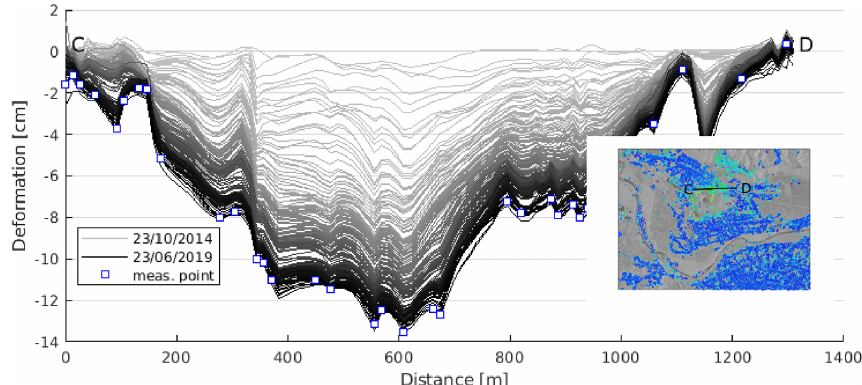
Figure 10. Progress of LOS surface deformation from descending pass Sentinel-1 data. Location of cross section is given in the insert. The shade of gray varies from light (October 2014) to dark (June 2016); blue squares show location of InSAR observations along the